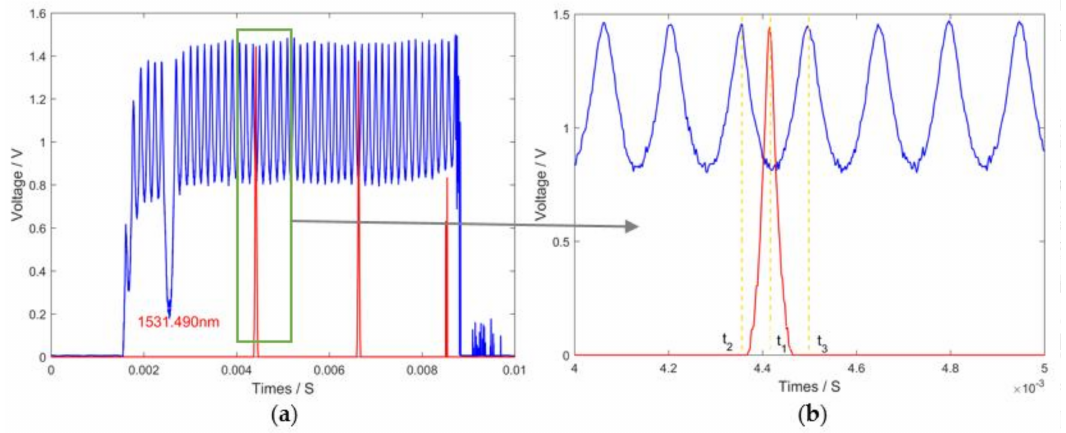
Figure 4. Diagram of the interrogation principle: ( a ) the original reflection spectrum of FBG sensor (in red) and transmission spectrum of comb filter (in blue); and ( b ) the detail diagram of the first grating in ( a